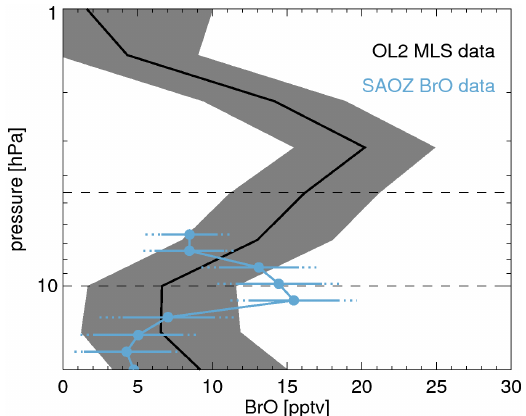
Fig. 10. Comparison of BrO MLS ascending-descending difference and SAOZ-BrO data from 24 August 2004 at 52 ◦ N. The SAOZ- BrO data have been scaled to the local time of the MLS observa- tions. Note that the peak around 10hPa is a consequence of this scaling. The MLS data corresponds to the average of the 19th to the 29th of August from 2004 to 2011 for the 10 ◦ latitude bin centered at 50 ◦ N. The MLS errors (gray shaded region) represents a com- bination of precision and accuracy, the SAOZ error bars indicate precision (solid) and precision plus the scaling uncertainty (dashed). The region between the black dashed lines indicates where the MLS ascending-descending difference are suitable for scientific use.